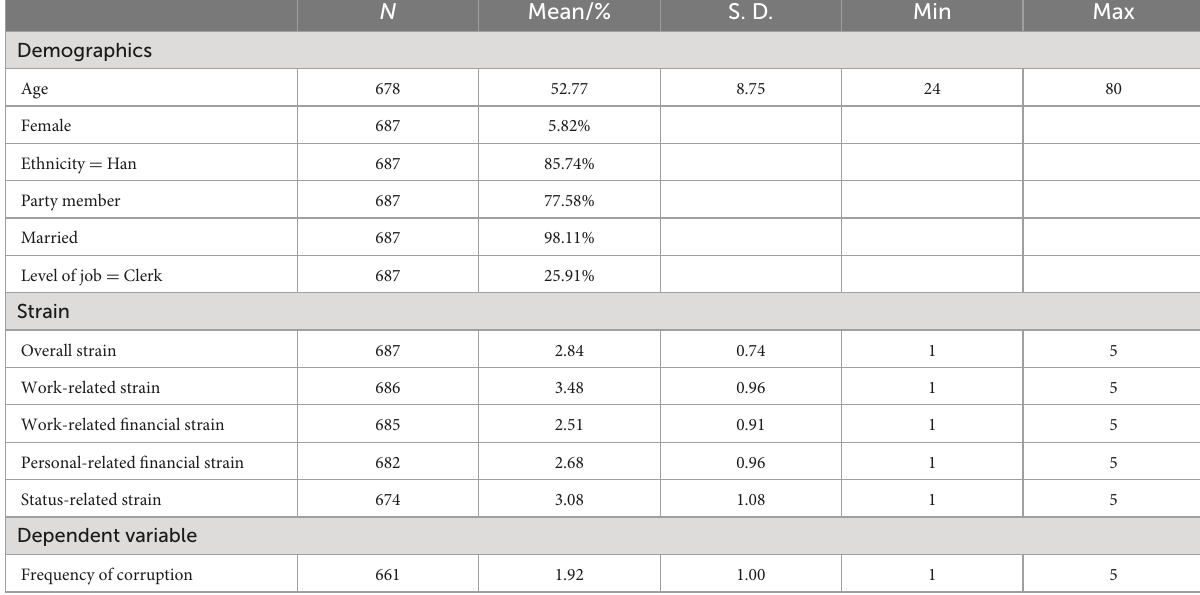
TABLE 1 Descriptive analysis.